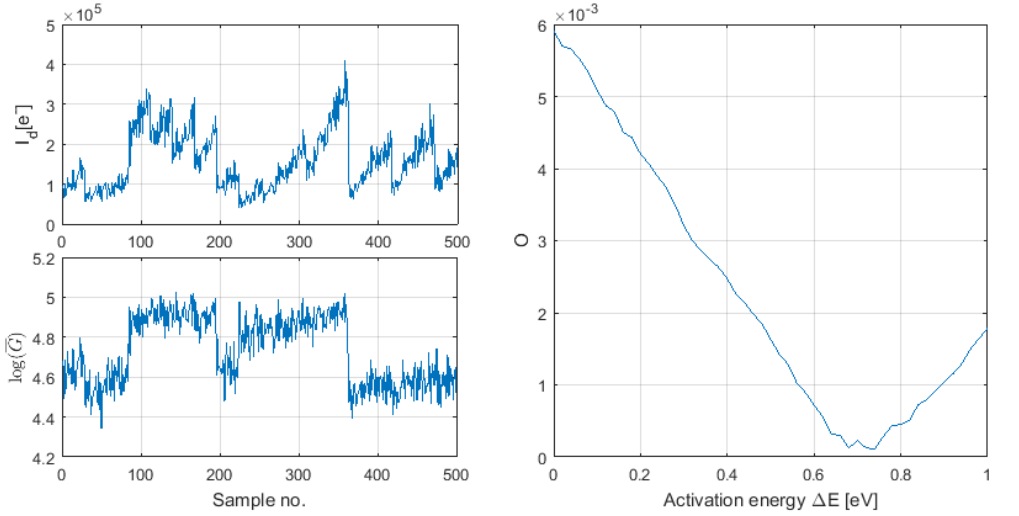
Figure 5. Example of outcomes during ∆ E search in a random pixel from BAb satellite (setup VelPup collected in 2018). On the left side: a part of dark series before (above) and after (below) normalization. On the right side: optimization curve ( O ) showing a clear minimum at 0.74